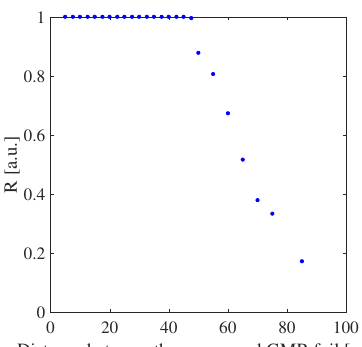
Figure 27. The effect of increasing distance between the source and an OrmoCore GMR grating sensor foil on the sensor response.